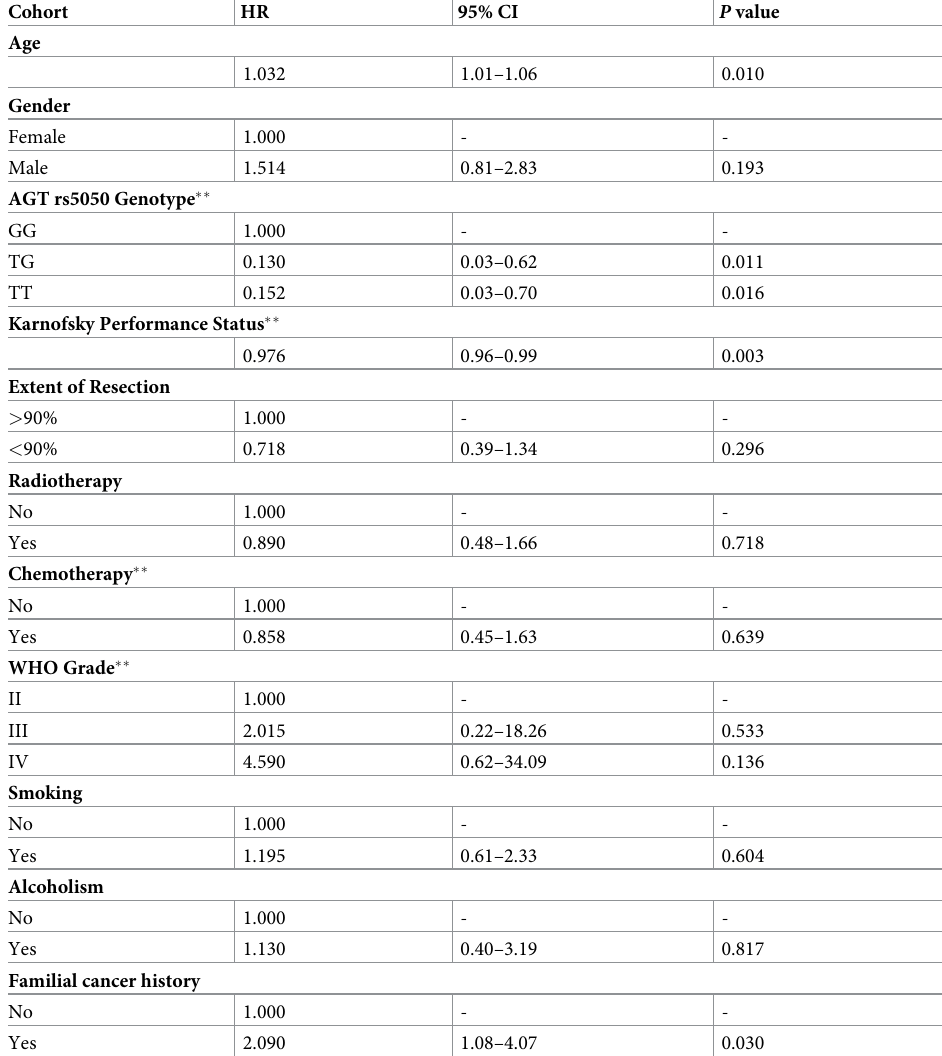
Table 3. Crude hazard ratios for